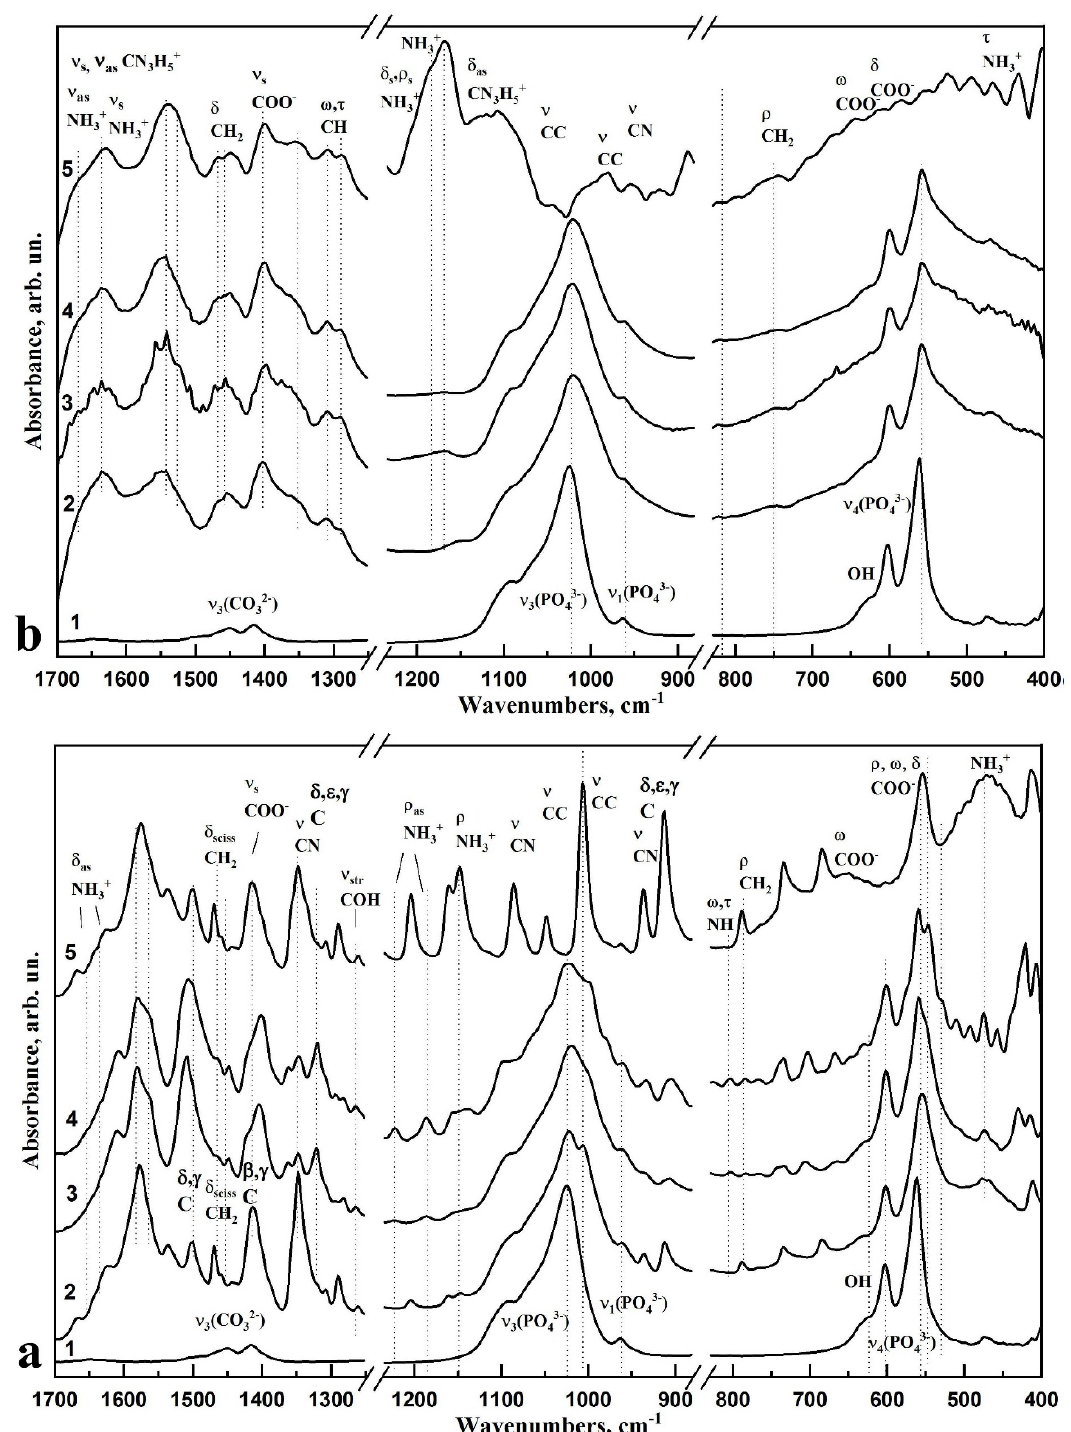
Figure 5. FTIR absorption spectra of biocomposite samples: ( a ) nanocrystalline B-type carbonate-substituted hydroxyapatite n-cHAp (curve 1), n-cHAp/L-LysHCl biocomposites obtained from solutions of pH ≤ 5 (curve 2), pH ≥ 7.5 (curve 3) and pH ≥ 11.2 (curve 4), L-LysHCl amino acid sample obtained by crystallisation from solution with pH ≥ 11.2 (curve 5); ( b ) nanocrystalline B-type carbonate-substituted hydroxyapatite n-cHAp (curve 1), n-cHAp/L-ArgHCl biocomposites obtained from solutions of pH ≤ 5 (curve 2), pH ≥ 7.5 (curve 3) and pH ≥ 11.2 (curve 4), L-ArgHCl amino acid sample obtained by crystallisation from solution with pH ≥ 11.2 (curve 5).